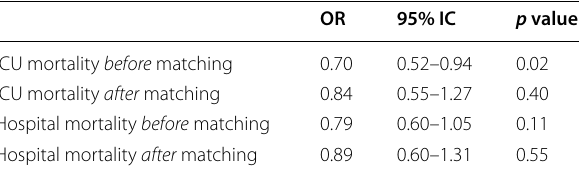
Table 6 Univariable logistic regression analysis assessing the relationship between the absence of identified ARDS risk factor and mortality before and after propensity